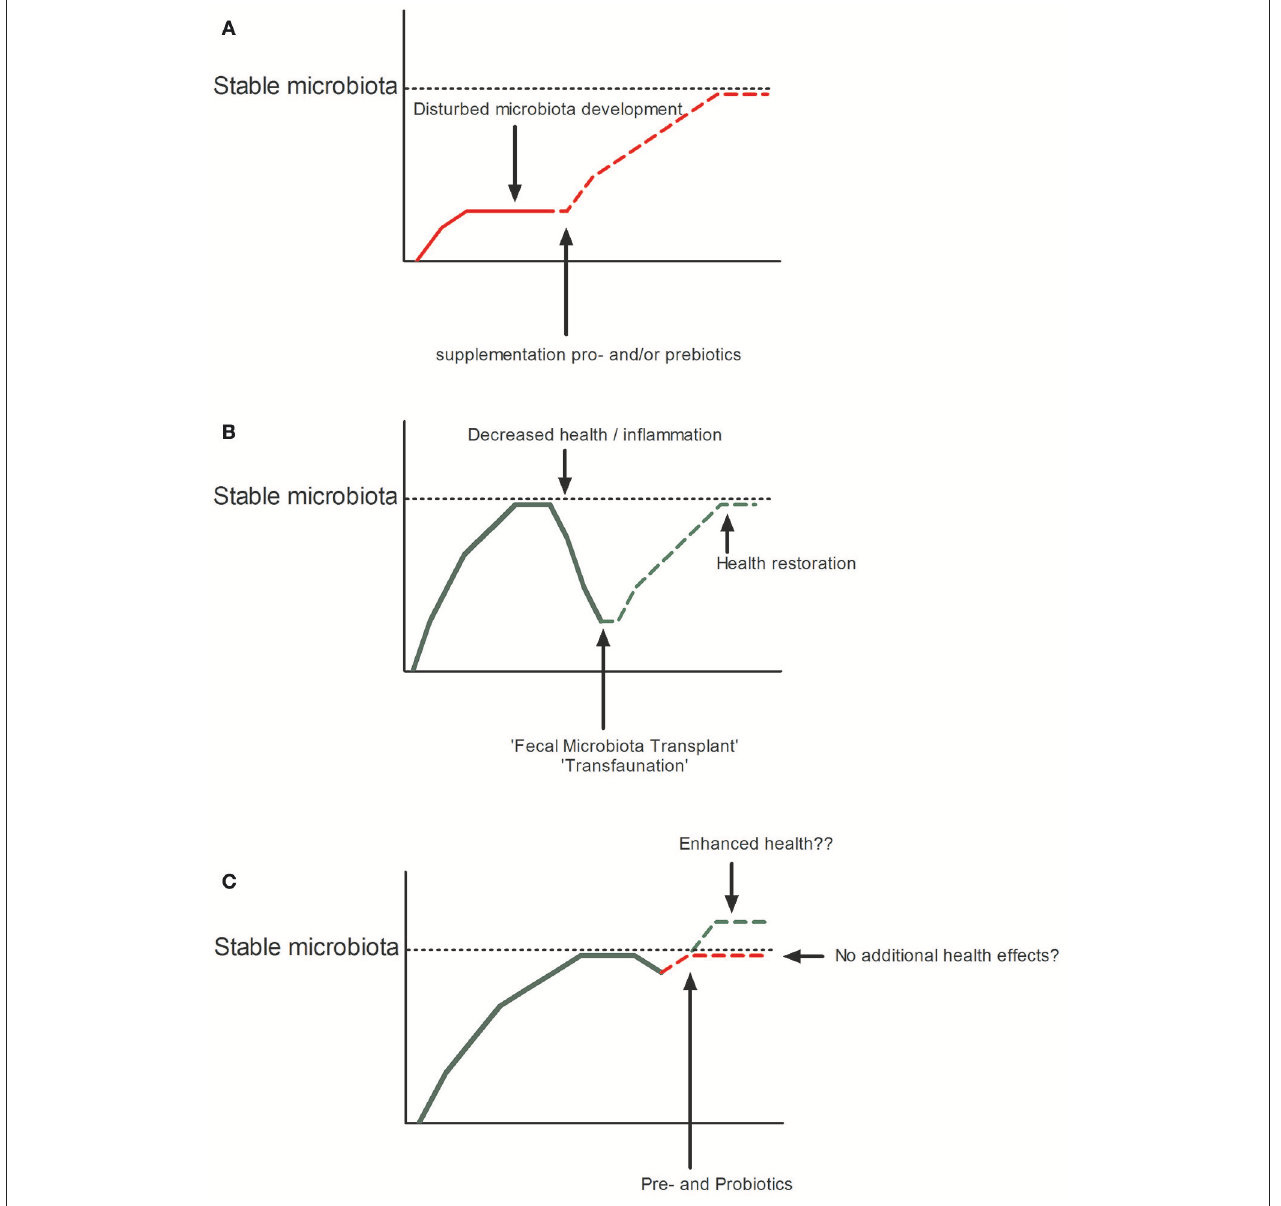
FIGURE 2 | Restoration or improvement of microbial homeostasis in disturbed ( A : by pro- or prebiotics or B : Fecal Microbiota Transplant) or undisturbed states (C)